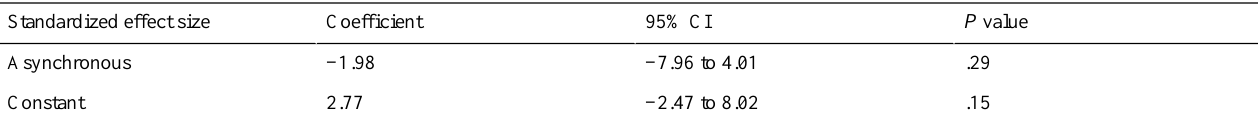
Table 8. Metaregression of synchronous and asynchronous interventions on anxiety outcome, analyzed using standardized effect